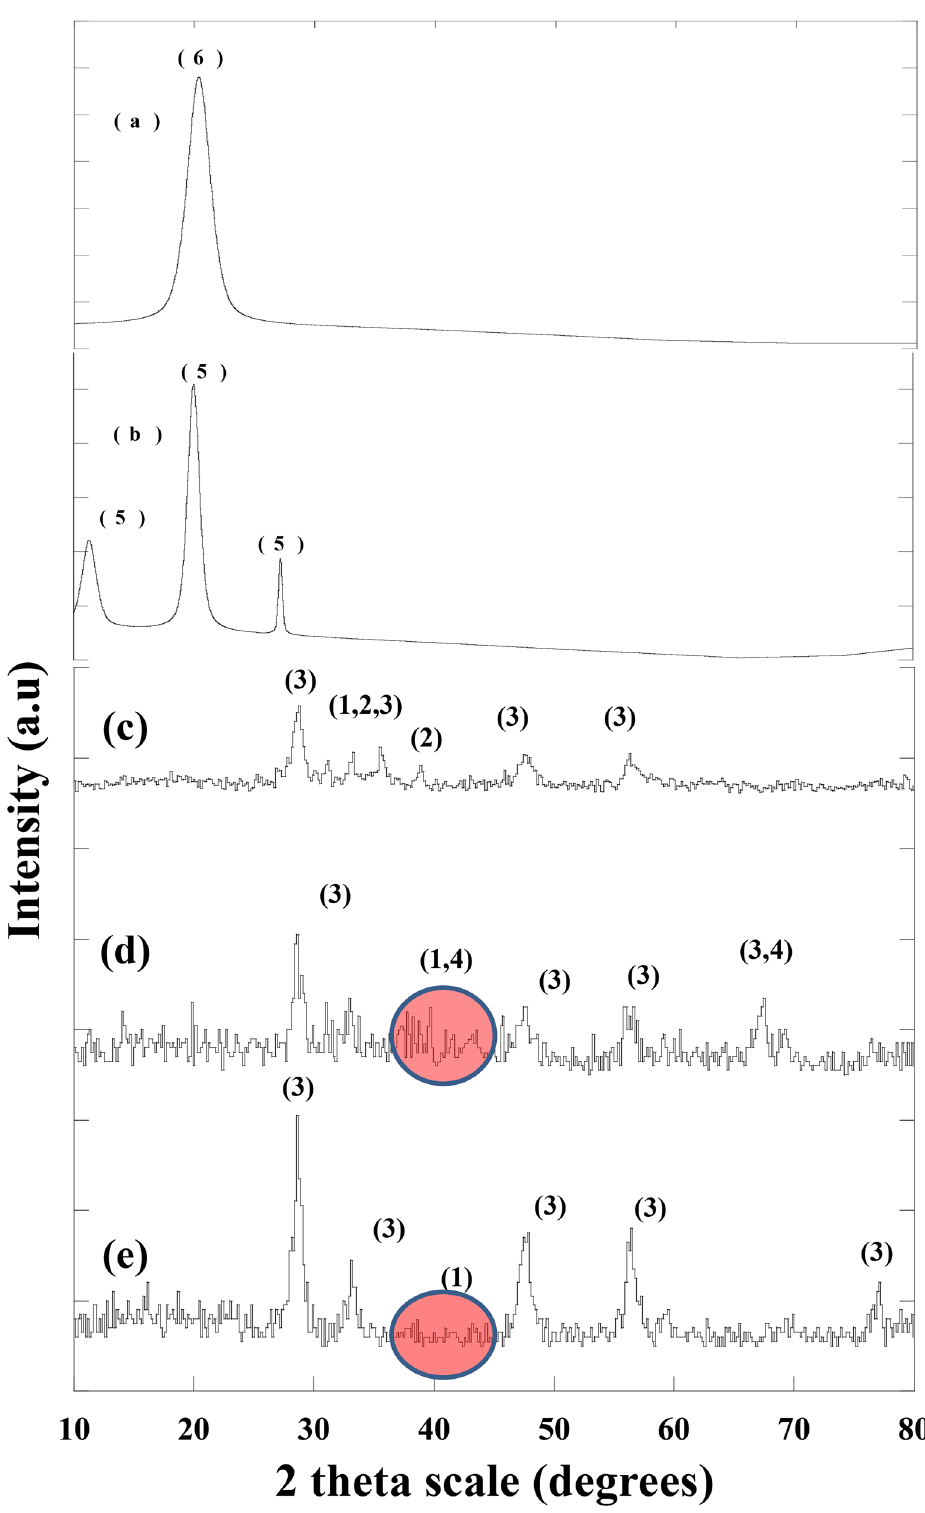
Figure 1. XRD pattern for: ( a ) chitosan-4-chloroacetophenone, ( b ) chitosan, ( c ) CuO–CeO 2 –Fe 2 O 3 , ( d ) CuO–